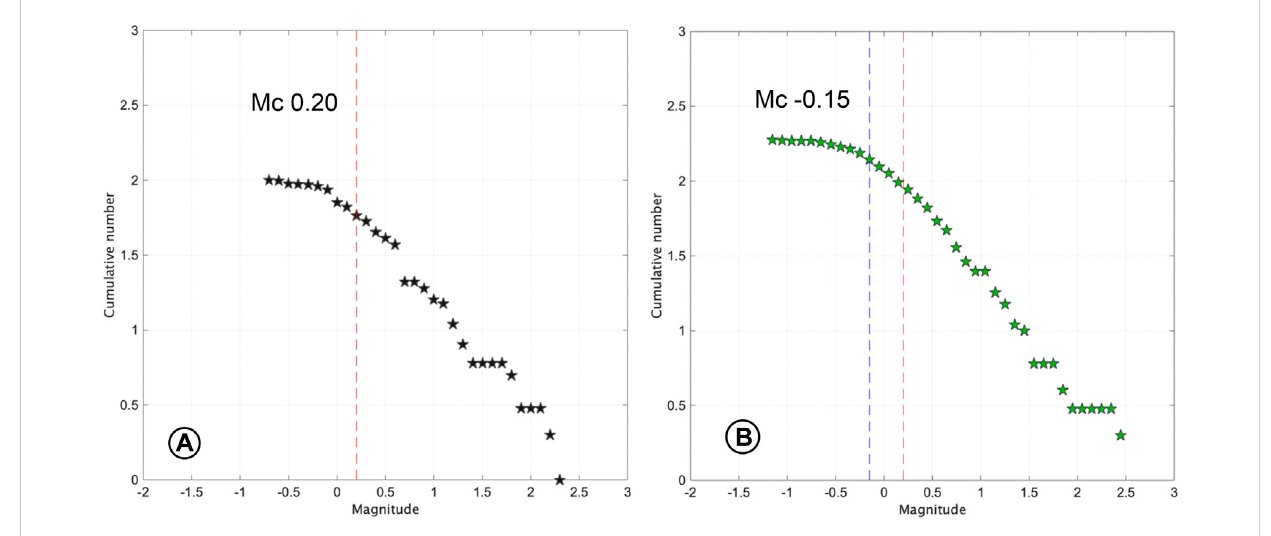
FIGURE 10 Gutenberg-Richter cumulative frequency-magnitude plots for (A) the JMA catalog and (B) the catalog retrieved in this study by the computational platform. Data are for the seismicity in the Nagano region (target area) during May 2011. The magnitudes are velocity magnitude, M v . The completeness magnitude M c for both catalogs is indicated with dashed